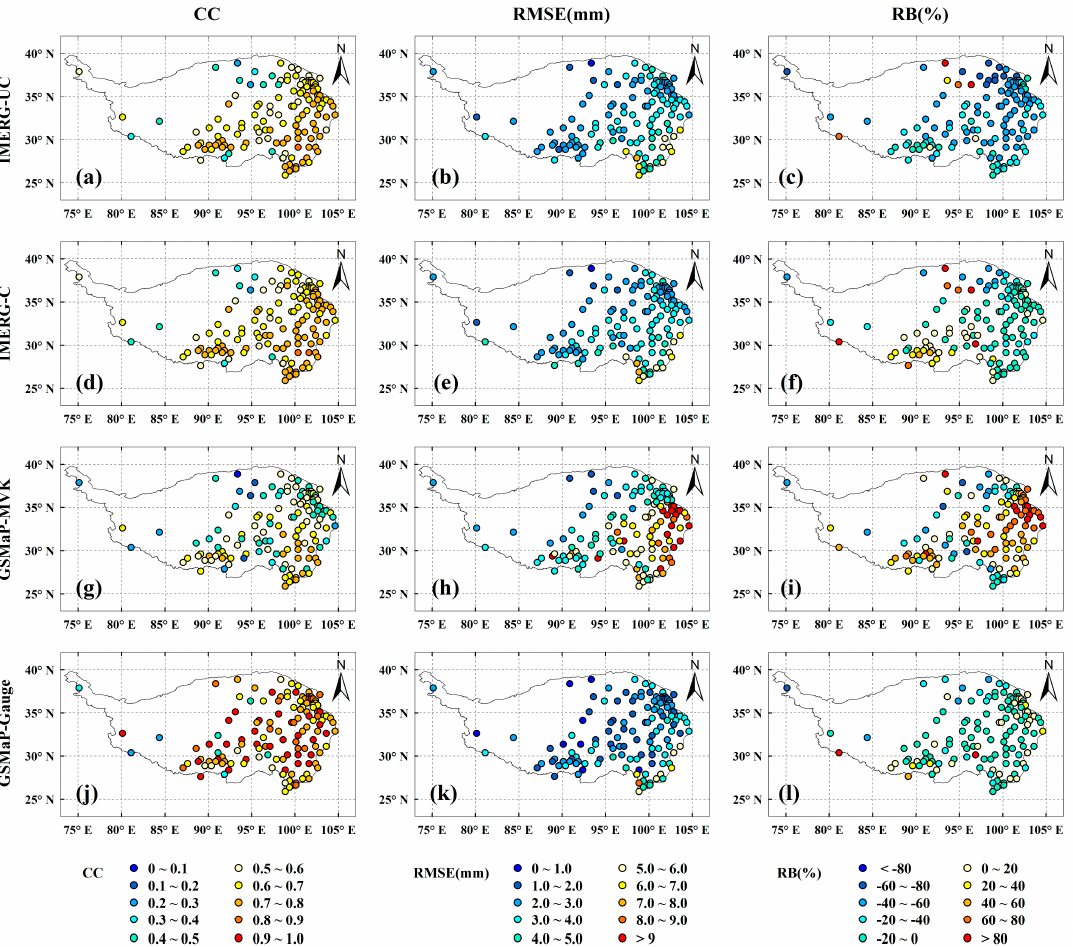
Figure 5. Spatial distribution of ( a , d , g , j ) correlation coefficient (CC); ( b , e , h , k ) root-mean-squared error (RMSE); and ( c , f , i , l ) relative bias (RB) between the four satellite precipitation estimates and CGDPA at the 132 grid central points.